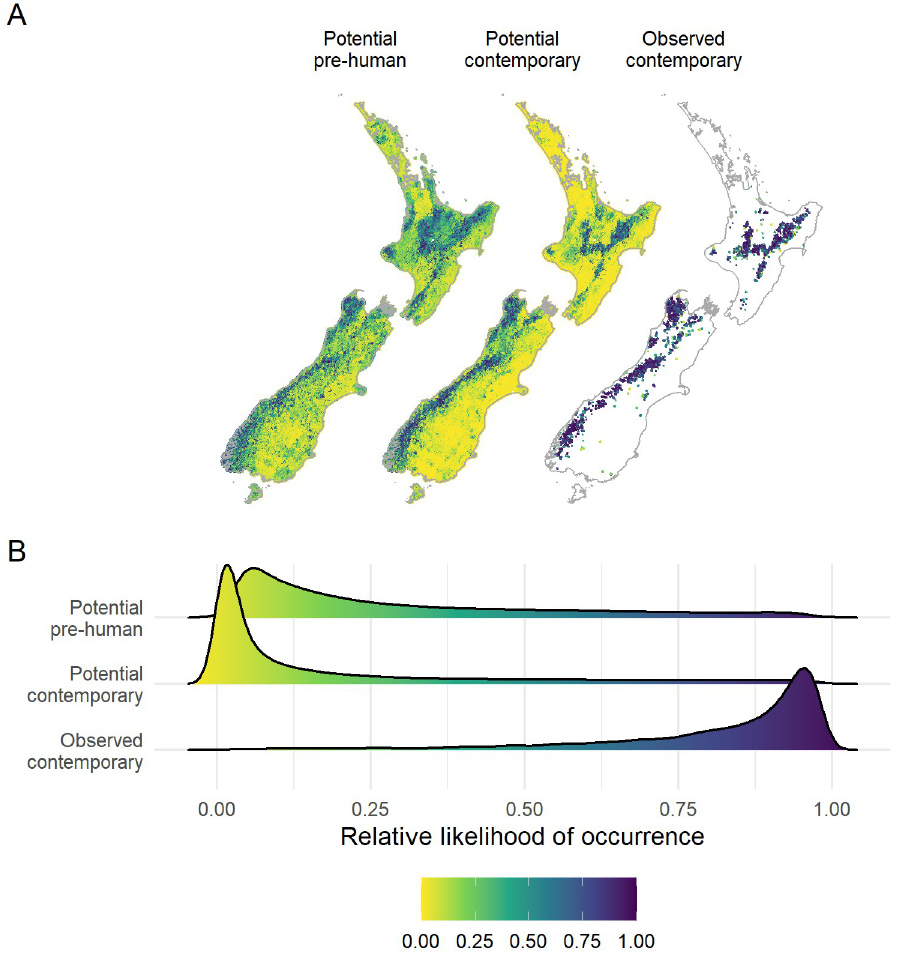
Fig 4. Predicted relative likelihood of occurrence for whio under three scenarios. A) Spatial distribution and B) density plots of the mean predicted relative likelihood of occurrence for whio prior to human arrival in New Zealand (potential pre-human), in contemporary habitat with the exclusion of predators (potential contemporary) and the observed distribution (observed contemporary). Potential values represent predictions from 200 bootstrapped simulations of a boosted regression tree model, while observed values are the potential contemporary predictions at reaches where whio were observed from